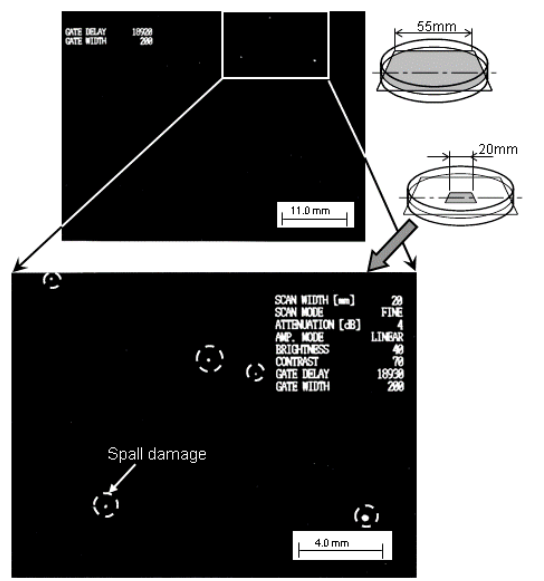
Figure 4. The spall damage in medium carbon steel generated after the fifth impact during low-velocity repeated impact tests. The exposed particular data (C-scan image at the 3.3 mm depth) were registered for the sample No. R6.